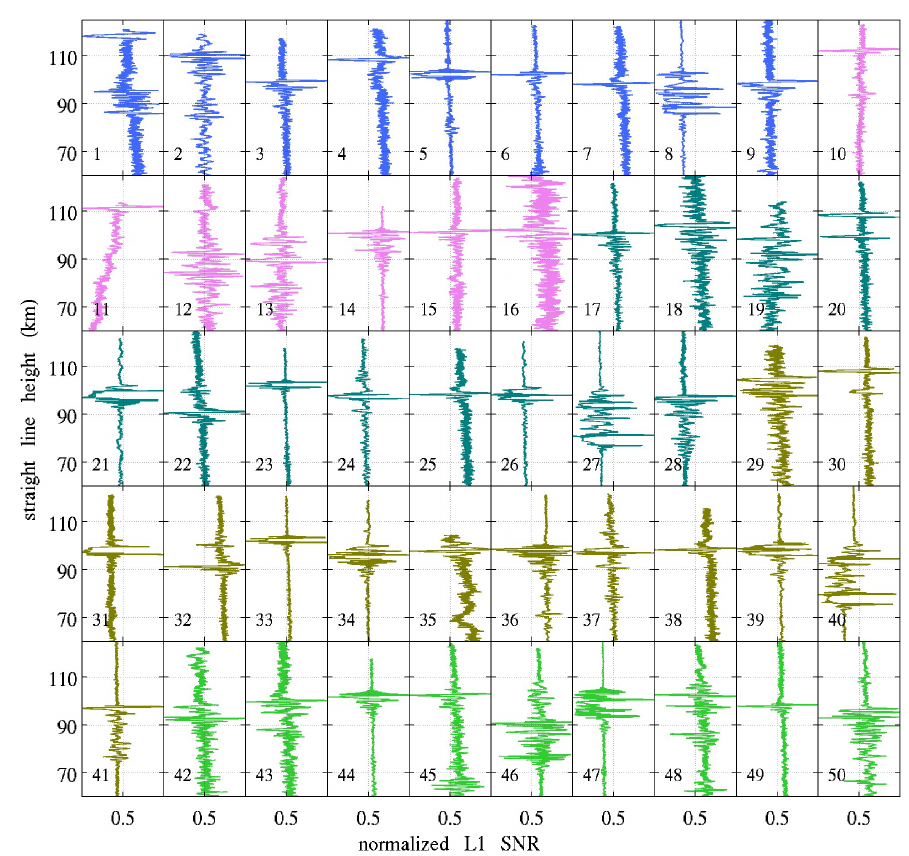
Figure 9. Straight line height variations of the normalized L1 SNR for the 50 COSMIC RO events shown in Fig. 8. Different colors represent different LEO satellites. Table 1. Latitude, longitude, ionosonde system type, and operation organization/country of the seven ionosondes used in the study.